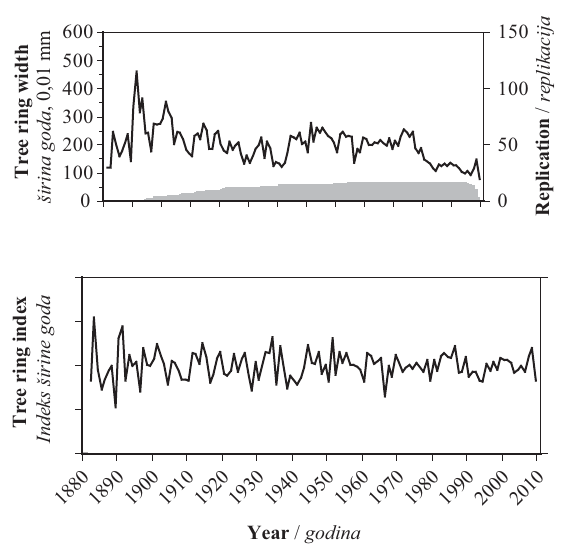
Figure 2 Oak tree-ring chronology of Kobiljak near Zagreb (HR1): raw-data chronology with replication (above) and detrended residual chronology (below); the optimally replicated part of the chronology extends from 1922 to 2008 and is 88 years long. It is based on 17 trees with subsample signal strength (SSS) >0.80